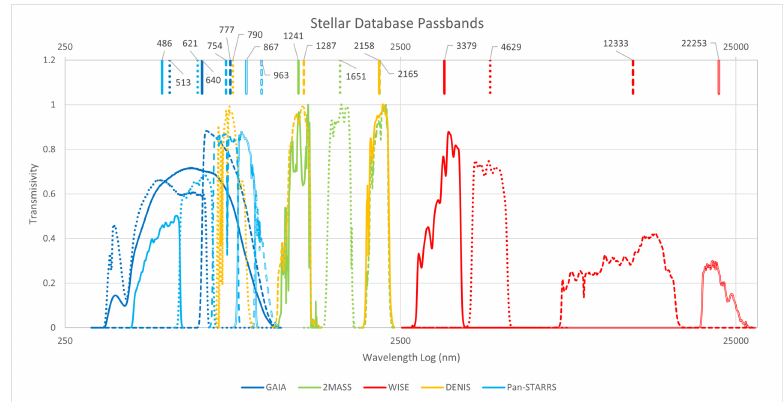
Figure 3. This plots shows all the passband functions used in our analysis, each normalized to unity. Colour corresponds to different databases, while dashing distinguishes different passbands. The vertical lines at the top indicate the transmisivity-weighted average of each passband, which are used to assign a single frequency value for the flux of each passband in figure